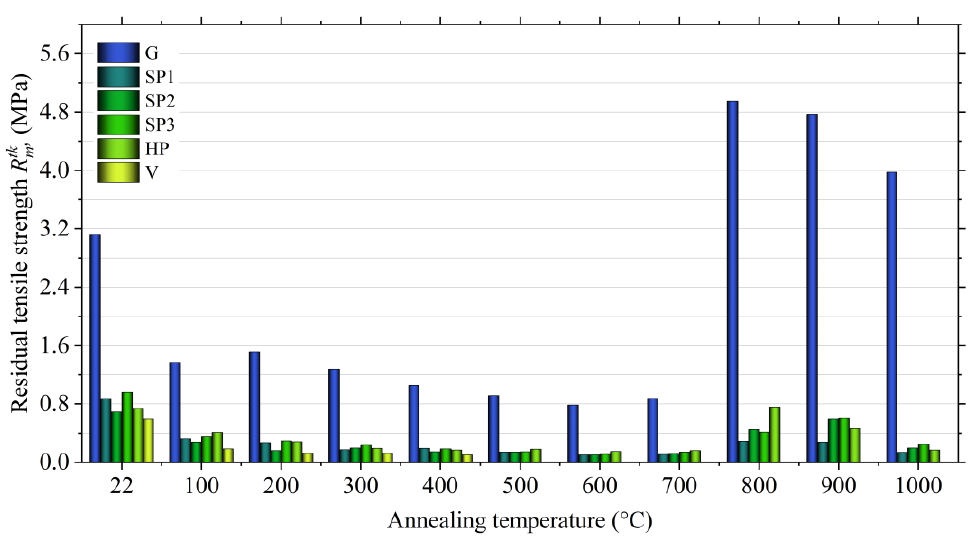
Figure 16. Final tensile strength ( R tk m ) of moulding sands with Geopol ® binder, depending on the type of additive. The second maximum strength occurs at the temperature of 800 °C and is 4.95 MPa.